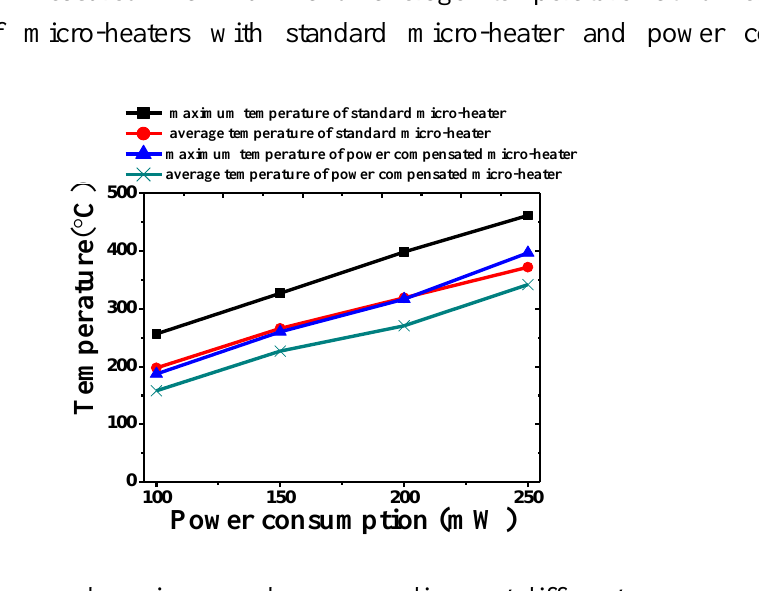
Figure 9. The measured maximum and average radiance at different power consumption of micro-heaters with standard micro-heater and power compensated